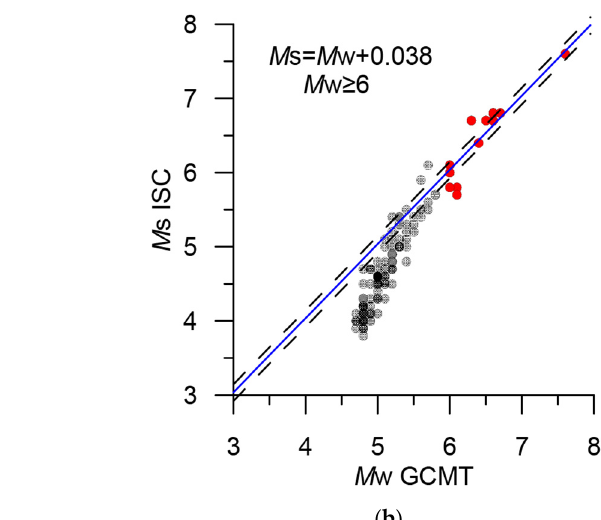
Table 5. Strong earthquakes in the Eastern Arctic.